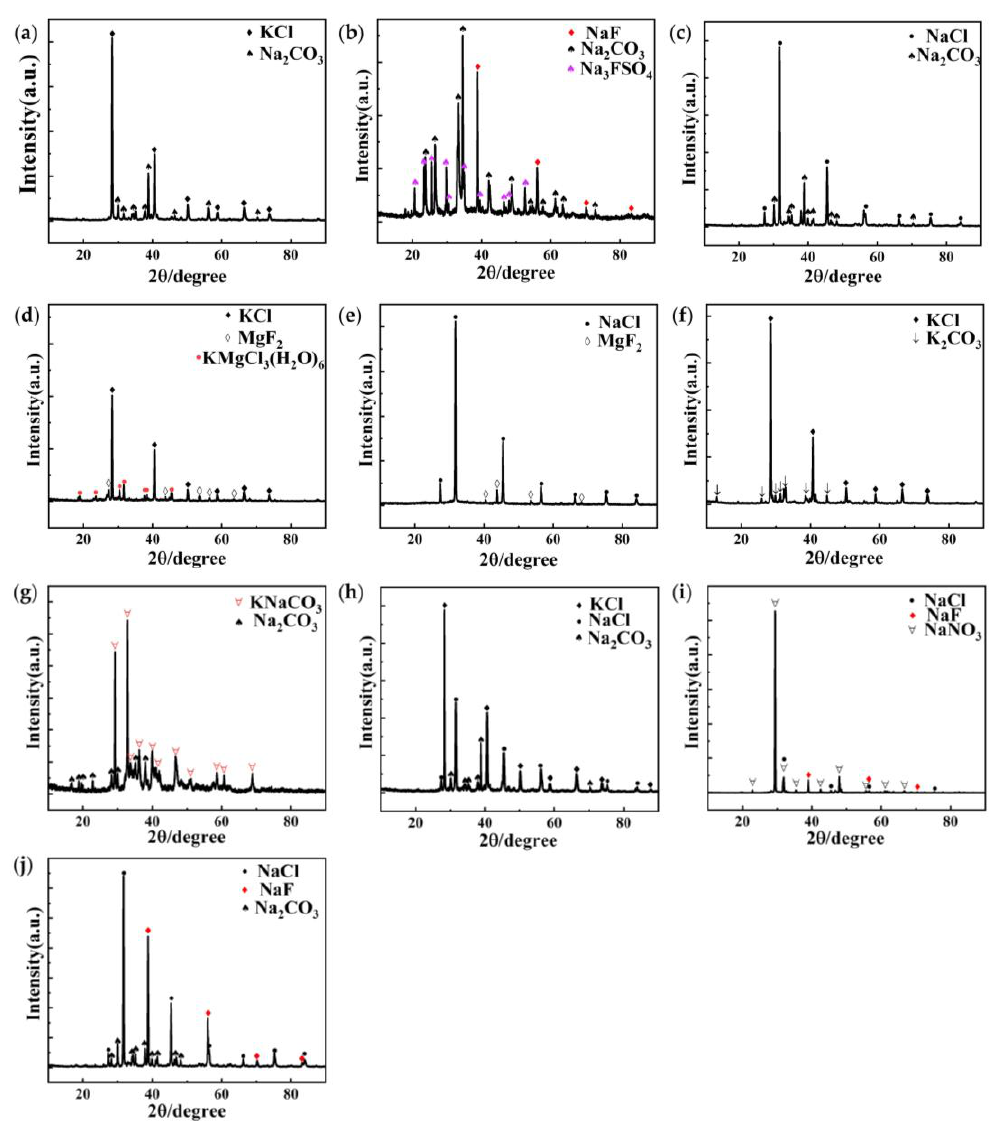
Figure 2. XRD spectra of the fluxes: ( a ) #1; ( b ) #2; ( c ) #3; ( d ) #4; ( e ) #5; ( f ) #6; ( g ) #7; ( h ) #8; ( i ) #9; ( j ) #10.